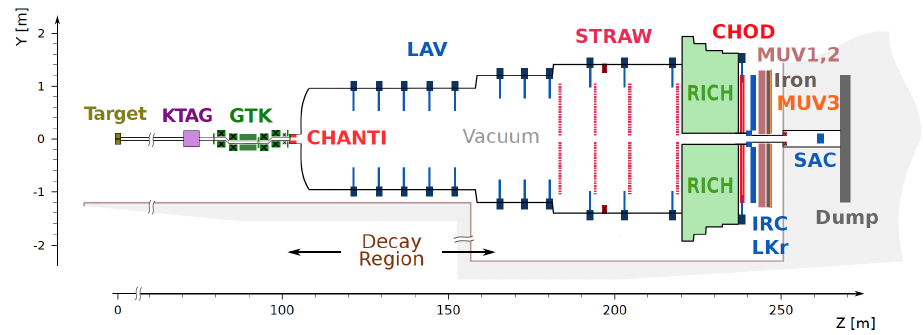
Figure 1. Schematic vertical section through the NA62 experimental setup. The main elements for the detection of the K + decay products are located along a 150 m long region starting 121 m downstream of the kaon production target. Useful K + decays are detected in a 65 m long decay region. Most detectors have an approximately cylindrical shape around the beam axis. An evacuated passage surrounding the beam trajectory allows the intense (750 MHz) flux of un-decayed beam particles to pass through without interacting with detector material before reaching the